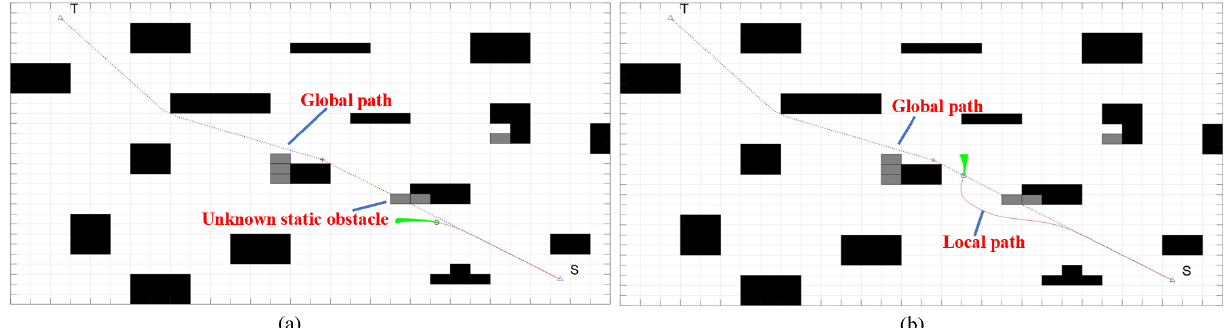
Figure 14. Dynamic path planning algorithm for FAGV returns a global path after avoiding dynamic obstacles. ( a ) FAGV detects a dynamic obstacle that is about to collide. ( b ) FAGV drives along the local path for obstacle avoidance. ( c ) FAGV returns the global path after obstacle avoidance.